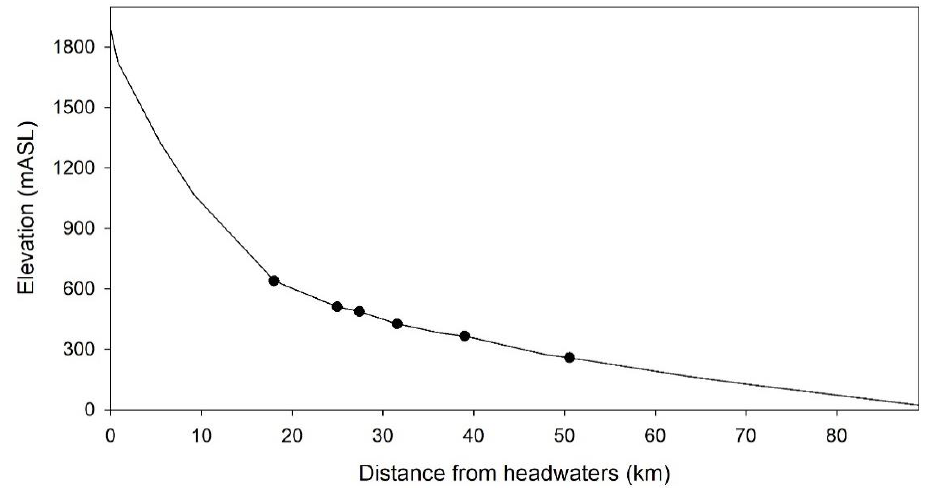
Figure 2. Stream temperature monitoring locations along the Fifteenmile Creek longitudinal profile in north-central Oregon, USA. Elevation is in meters above sea level (mASL).